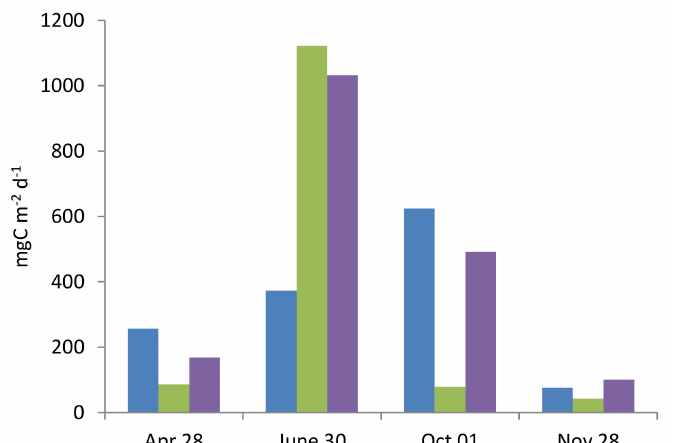
Figure 6. Changes in the share of biomass of phytoplankton (blue), zooplankton (red), and bacterio- plankton (green) in the total plankton biomass in different periods of 2021.